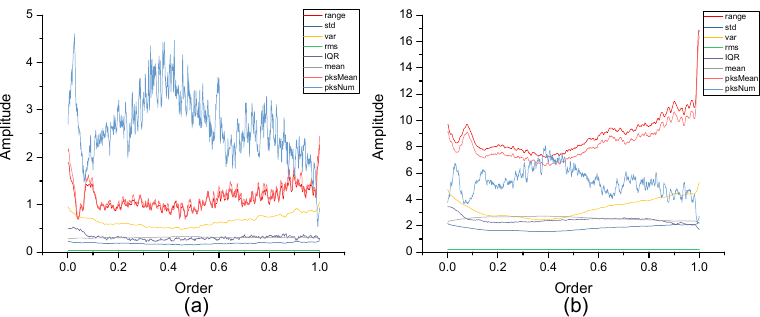
Figure 5. Standard deviation and mean of eight features of the walk action. ( a ) The standard deviation of each feature, ( b ) The mean of each feature.